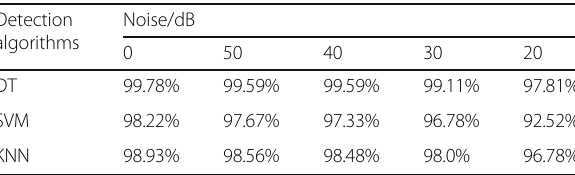
Table 3 Comparison of recognition accuracy of different detection algorithms Detection algorithms